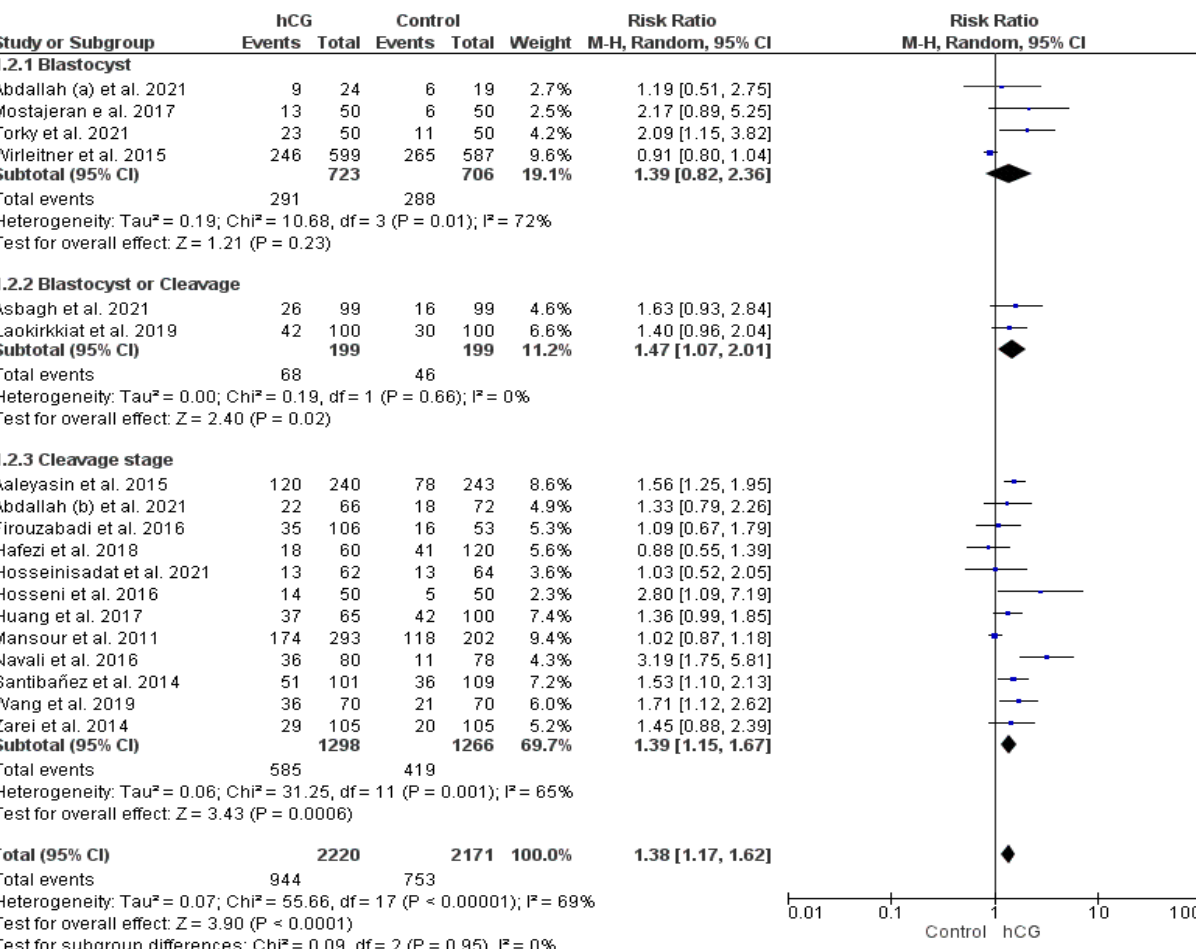
Figure 2. Forest plot showing the effect of intrauterine hCG injection versus the control group on clinical pregnancy rate.